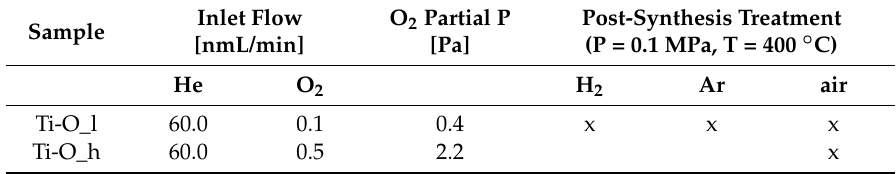
Table 1. Gas flow and O 2 partial pressure during the synthesis of TiO x NPs. The total pressure was 260 Pa. The samples were examined as-prepared and after being subjected to different thermal treatments as